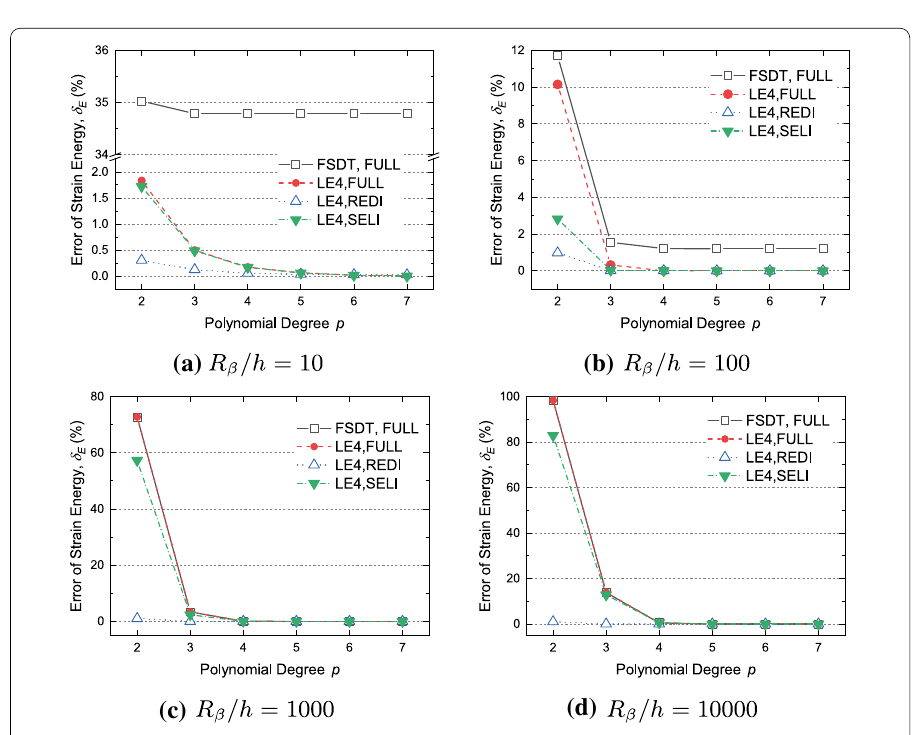
Fig. 14 Convergence regarding the strain energy of FE models for the simply supported cylindrical panels under bending, for various radius-to-thickness ratio R β /